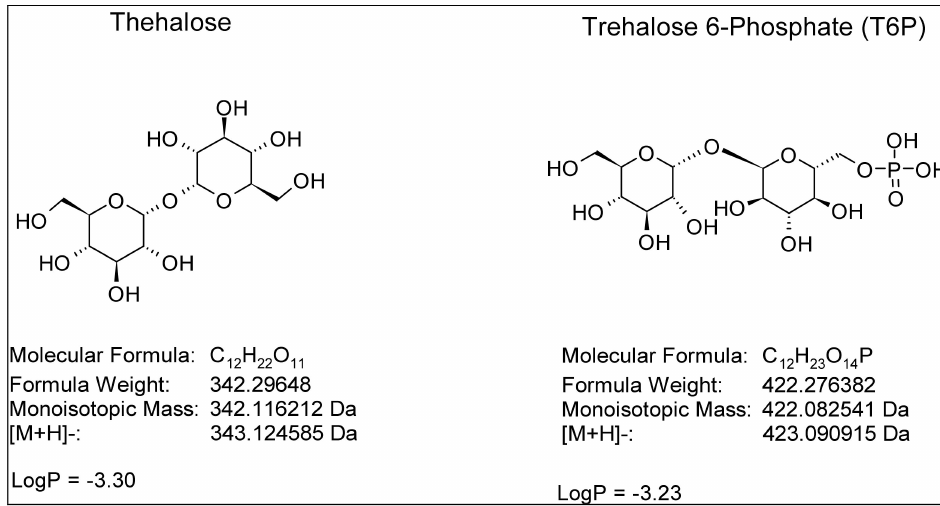
Figure 1. Structure and properties of trehalose and trehalose